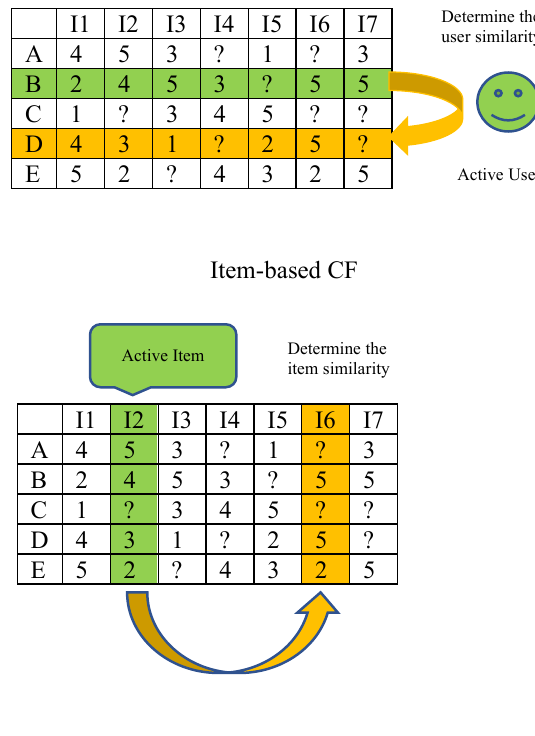
Figure 3. Types of Memory-Based CF